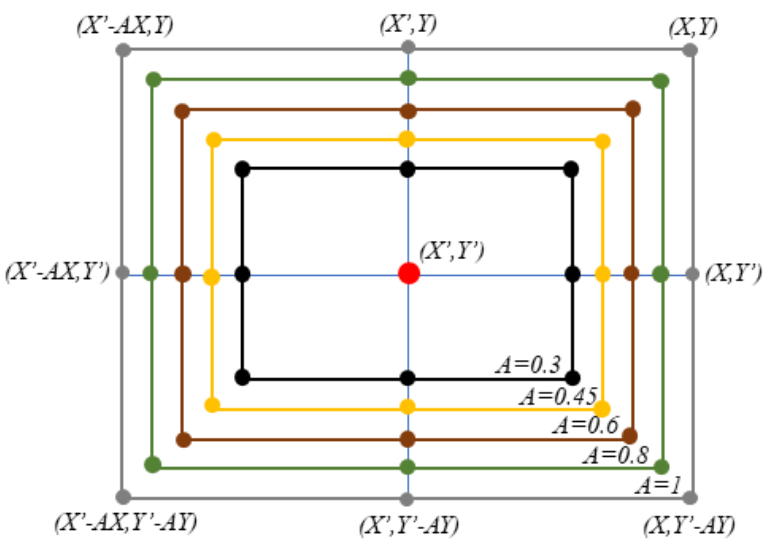
Figure 1. The model of the decreasing enclosing